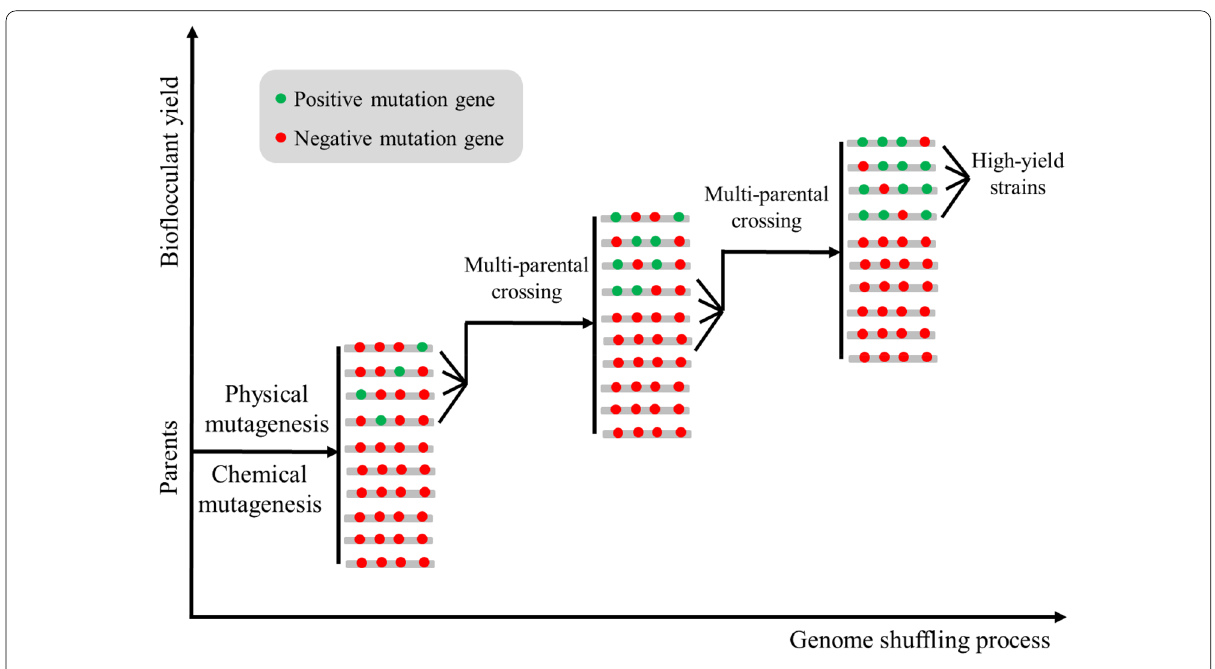
Fig. 2 Flowchart of microbial flocculant producing bacteria modified by genome